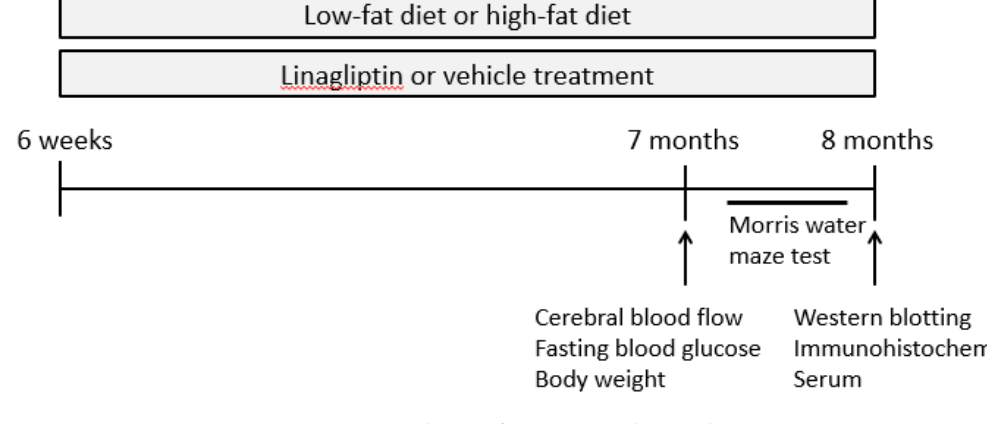
Figure 7. Scheme of experimental procedure.